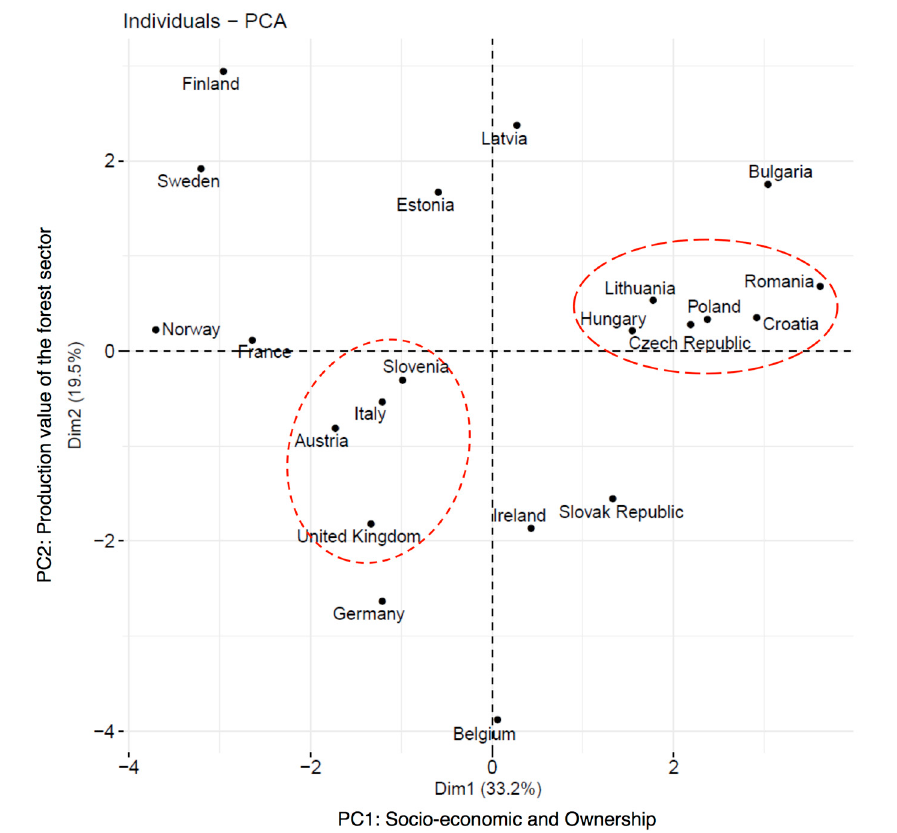
Figure 2. Countries score for the first and second PCs.